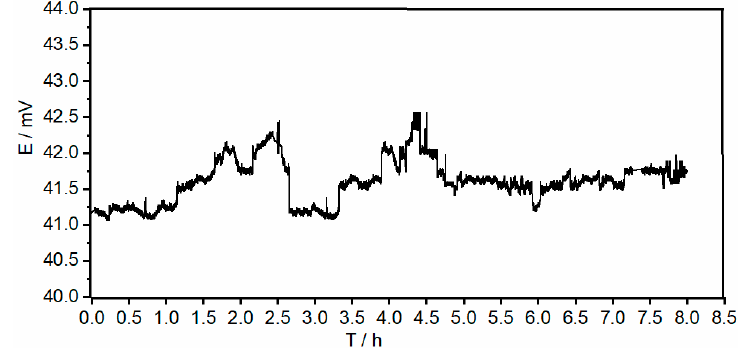
− 3 M KBr solution for 8 h.